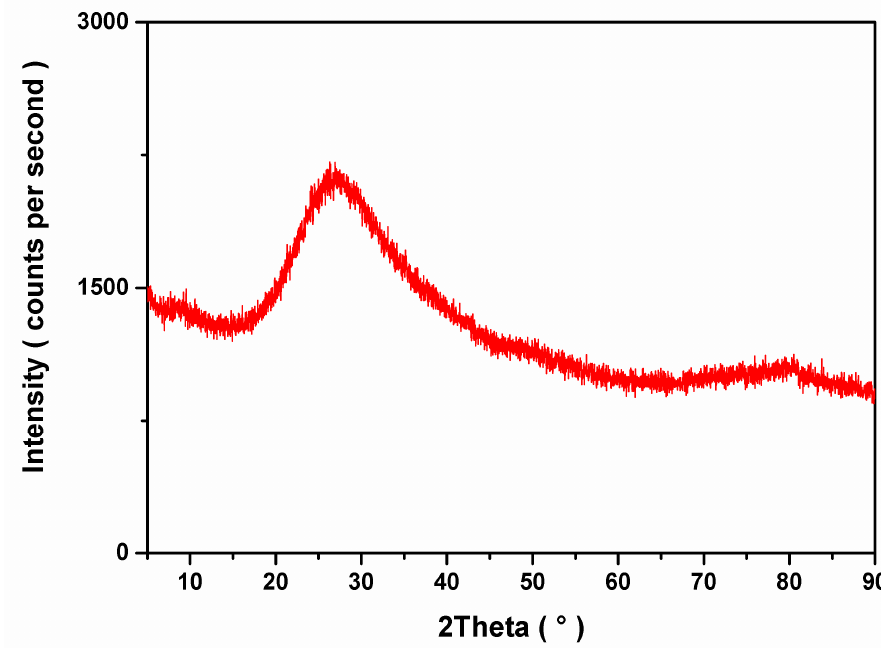
Figure 3. XRD patterns calcined at 500 °C—amorphous character.